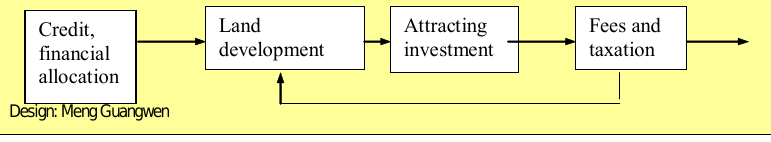
Large-Scale Circulatory Land and Industrial